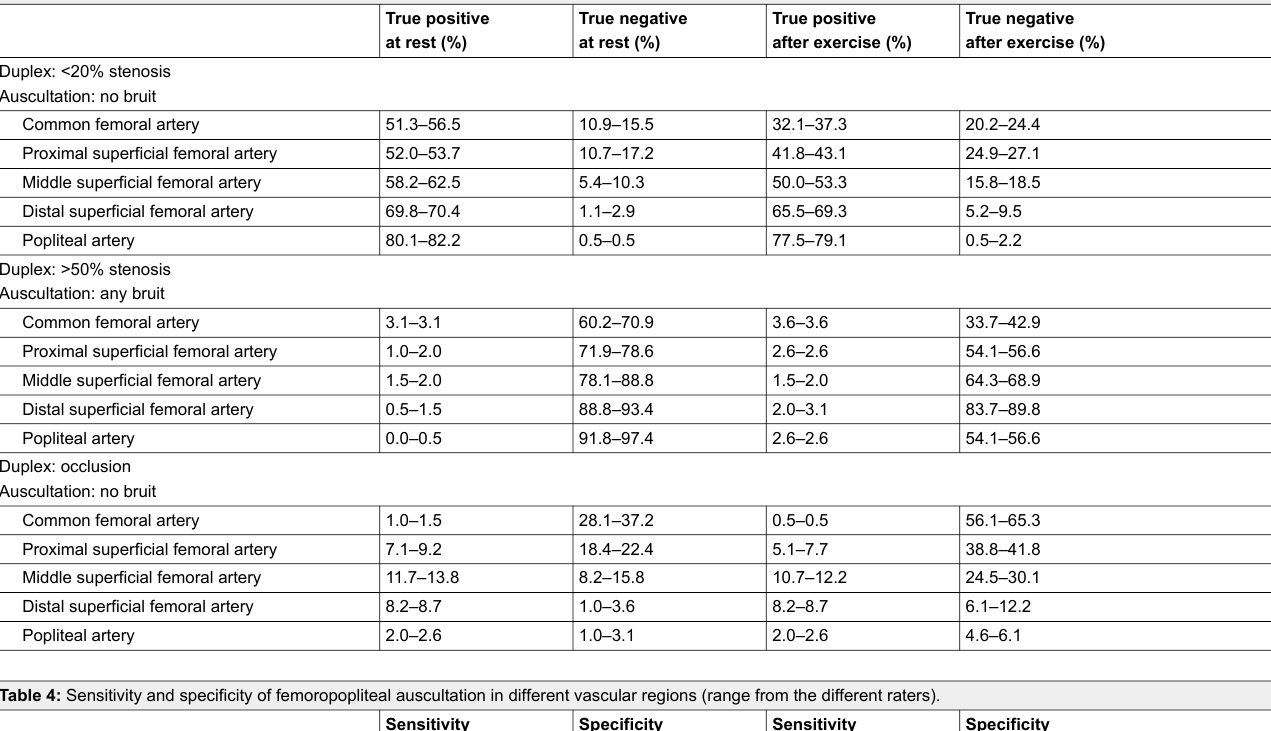
Table 3: True positive and true negative results of femoropopliteal auscultation in different vascular regions (range from the different raters).